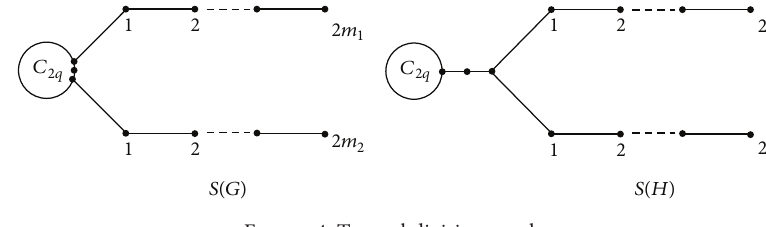
Figure 4: Two subdivision